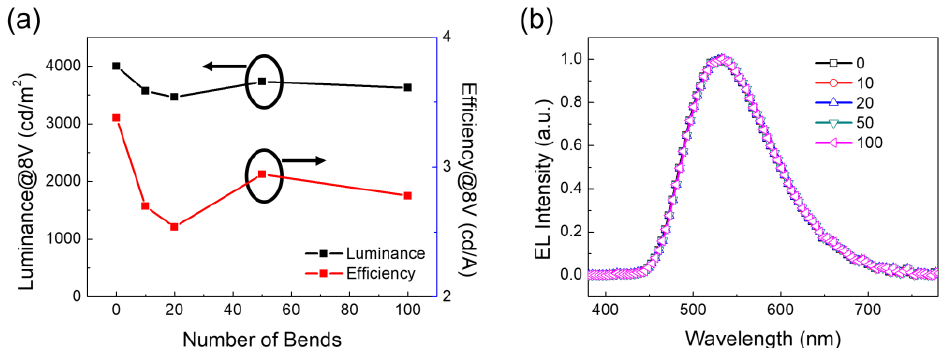
Figure 5. Mechanical stability of the flexible OLEDs. ( a ) Luminance and efficiency at 8 V as a function of the number of bending cycles. ( b ) Comparison of EL spectra before and after repeated bending.